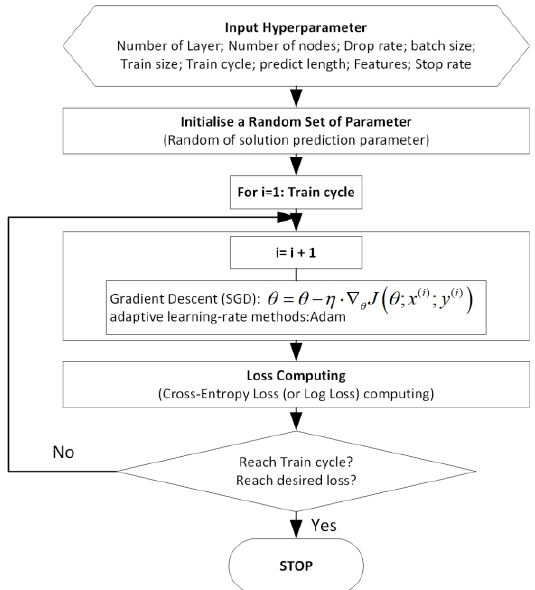
Figure 6. LSTM prediction flow chart.